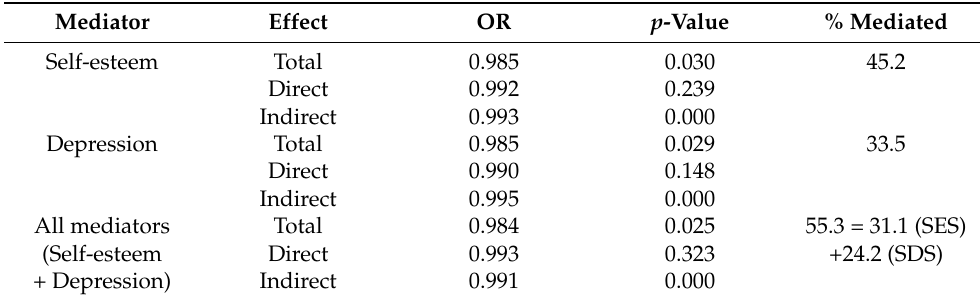
Table 4. Self-esteem and depression as mediators among the relationship between suicide attempts and perceived social